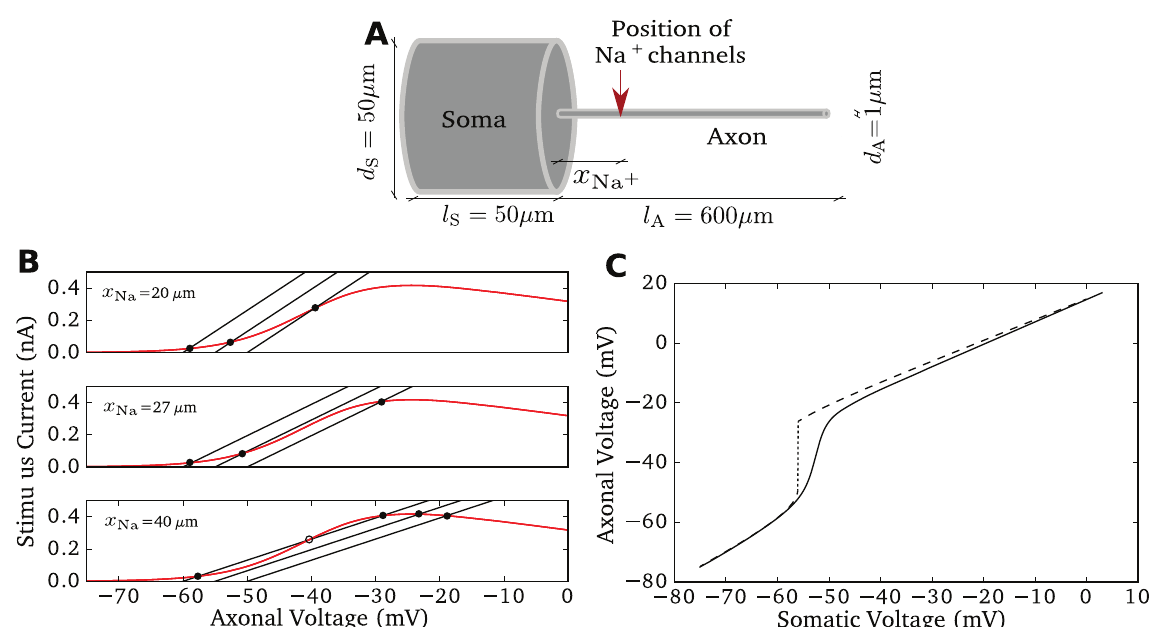
Fig 1. Model properties. A Sketch of the model morphology: soma and axon are modeled as cylinders. The sodium conductance is positioned at x Na and the stimulus current is injected at the middle of the soma. For simulation and model details see Methods. B Bifurcation of axonal voltage, replicating Fig 2 of [31]. Sodium current (red) and lateral currents (black, with somatic voltage fixed at − 60mV, − 55mV, − 50mV respectively) are plotted as a function of axonal voltage at different x Na . The intersection points between the black curve and the red curve indicate stationary axonal voltage given the somatic voltage. For large x Na = 40 μ m, the first intersection point changes discontinuously for increasing somatic voltage. C Axonal voltage plotted against somatic voltage for two conditions with x Na = 40 μ m. Only when the somatic voltage is artificially fixed to a slowly increasing potential (dashed), a sudden jump in the axonal voltage occurs (dotted), when the voltage control of the axonal voltage is lost around − 55mV. In a dynamic situation, here a current clamp with injection of a constant current driving firing at 5 Hz, this jump disappears (solid line), the transition is more